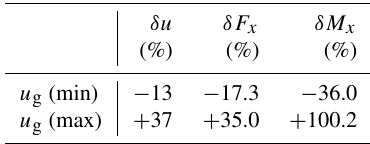
Table 3. Gust-induced peak load during the EOG on the rotor in relation to the constant blade